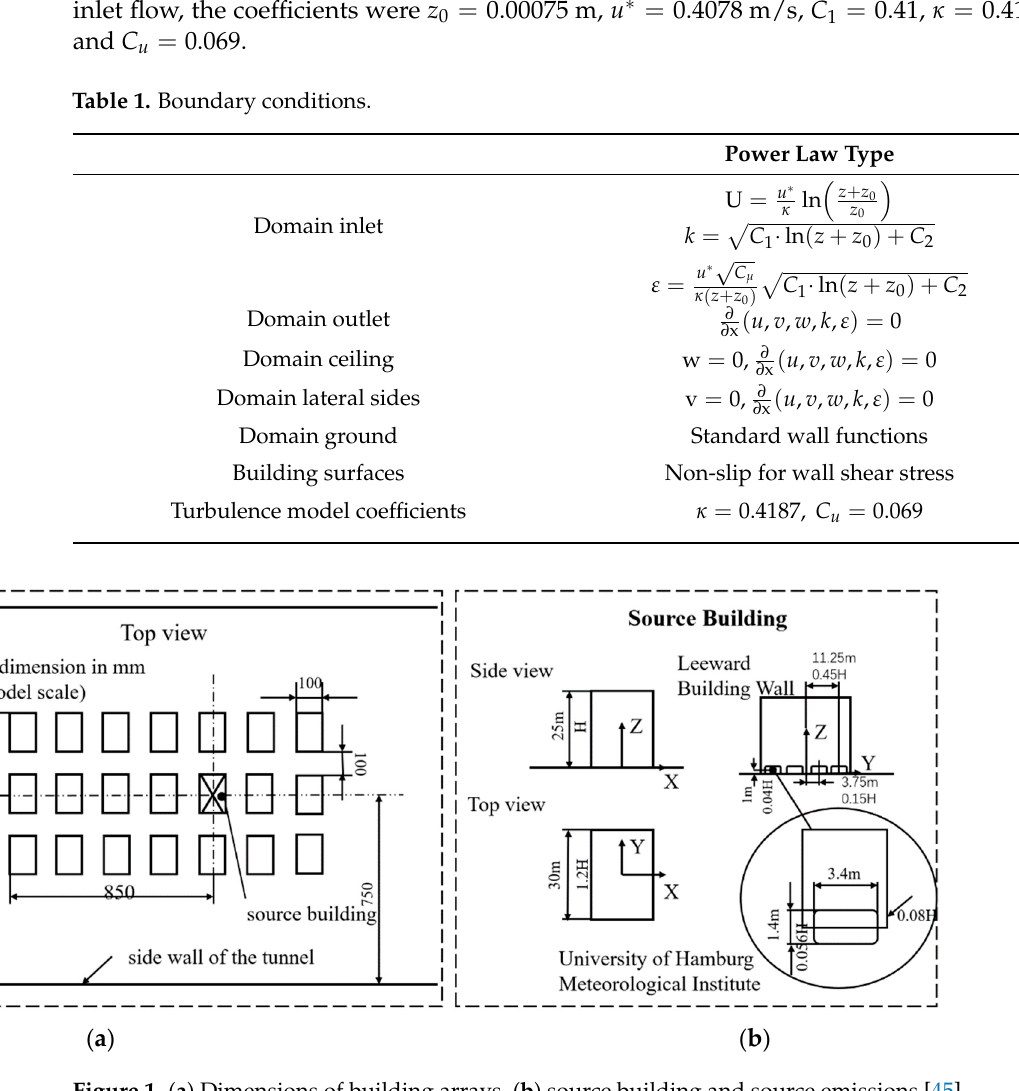
Table 1. Boundary conditions.